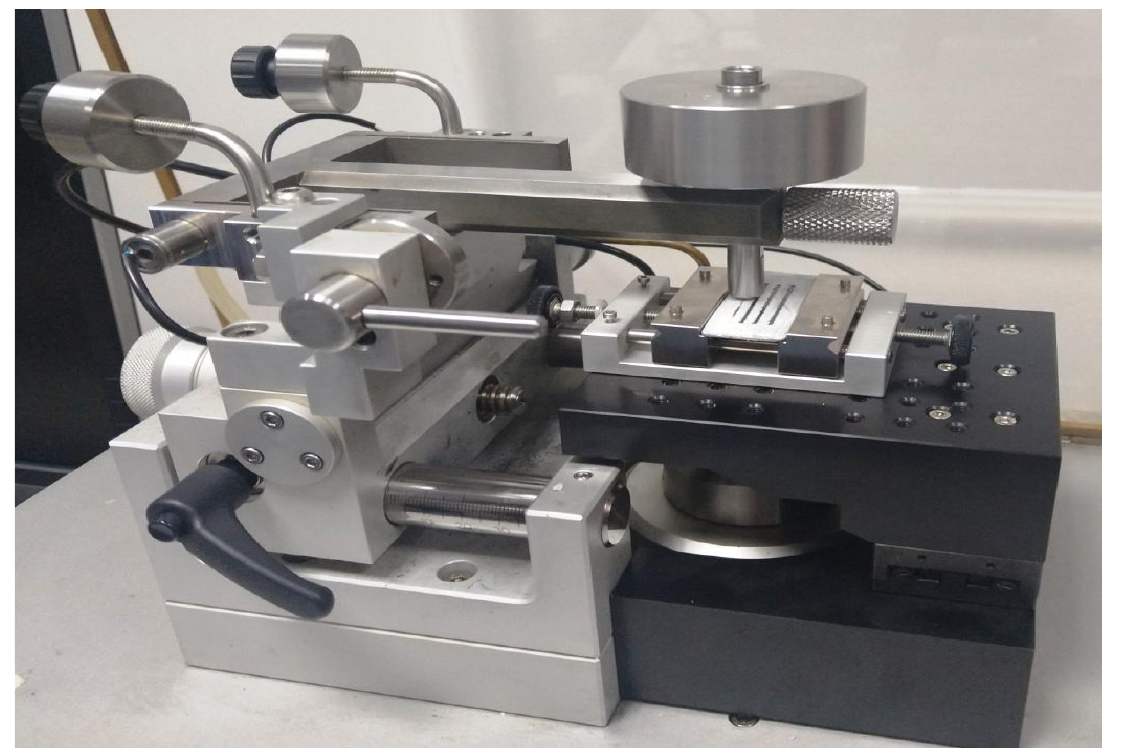
Figure 3. Tribometer used in the abrasibility testing of the coatings protecting roofing sheets.